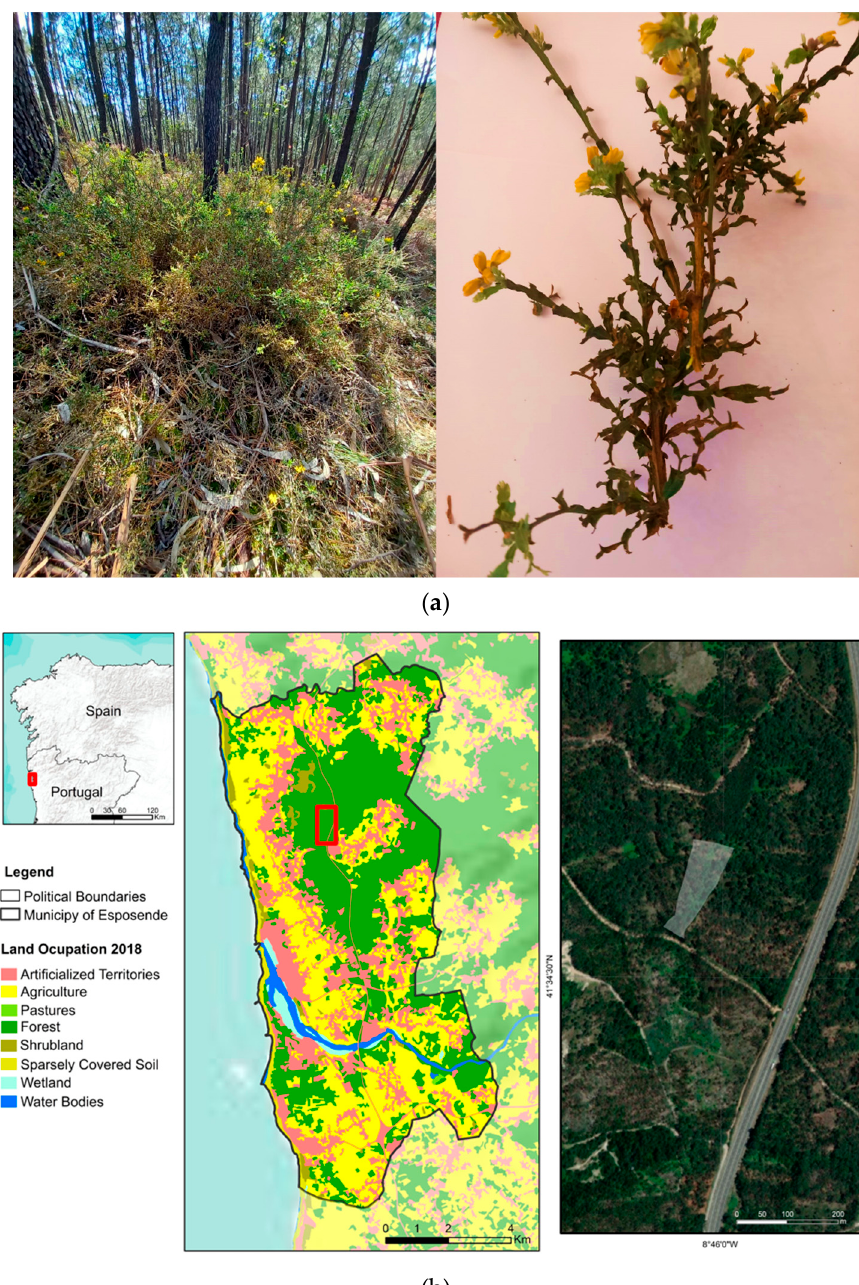
Figure 1. P. tridentatum collected specimen ( a ) and spatial representation of the P. tridentatum collection area (area inside red box or area highlighted) ( b ).